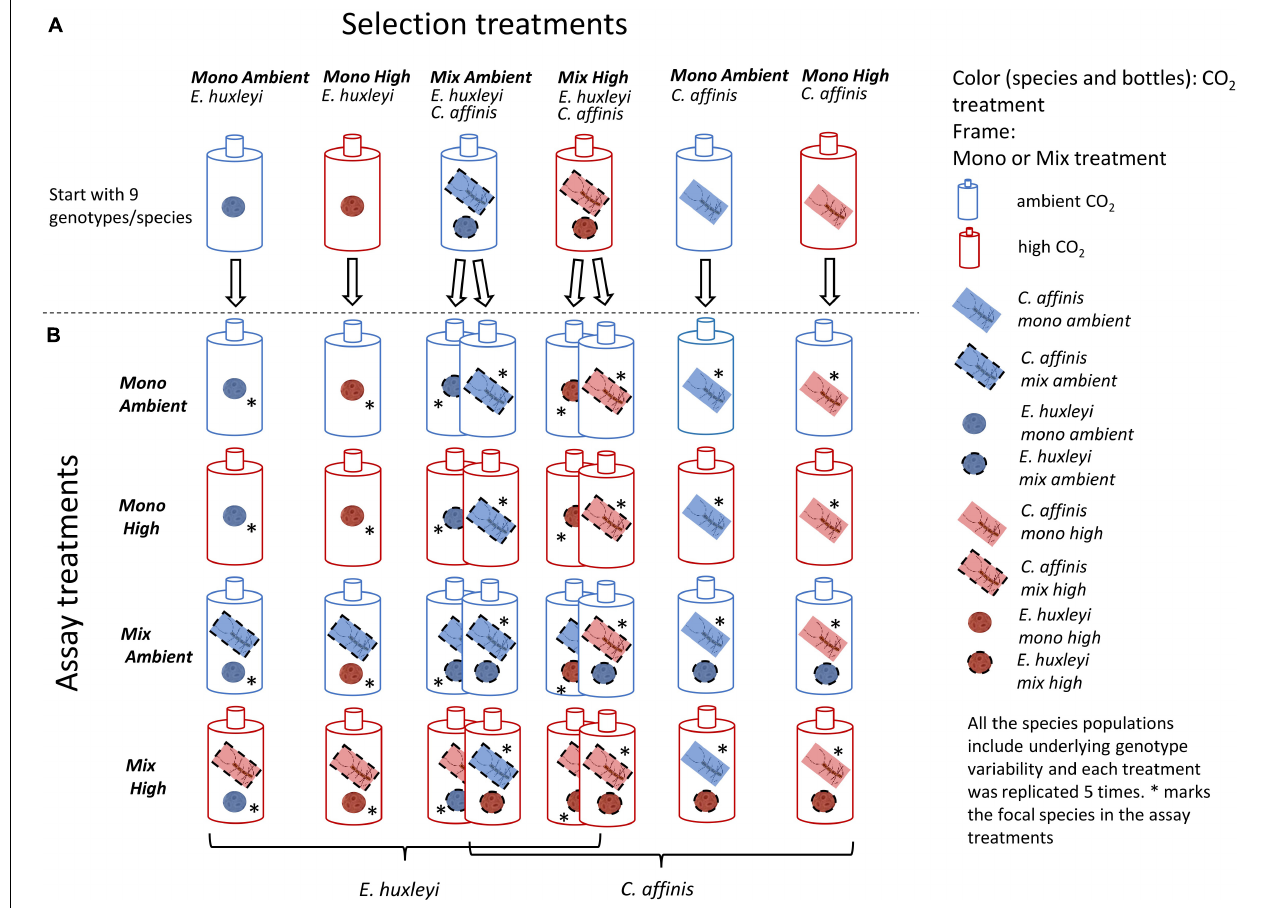
FIGURE 1 | Set up of Selection and Assay experiments: Here the schematic setup of the selection phase of the experiment is depicted in the top row (A) . The colors show the CO 2 treatments, whereas the frames of the species show mono or mix treatment. All species populations were started with 9 genotypes each. Each treatment consisted of 5 replicates. In the reciprocal assays, all cultures of both species were exposed to all possible treatments (four rows below) thus resulting in a fully crossed assay set-up (B) . The 16 resulting assay treatments are shown for each species. The star shows which of the species was the focal species in the mix assay